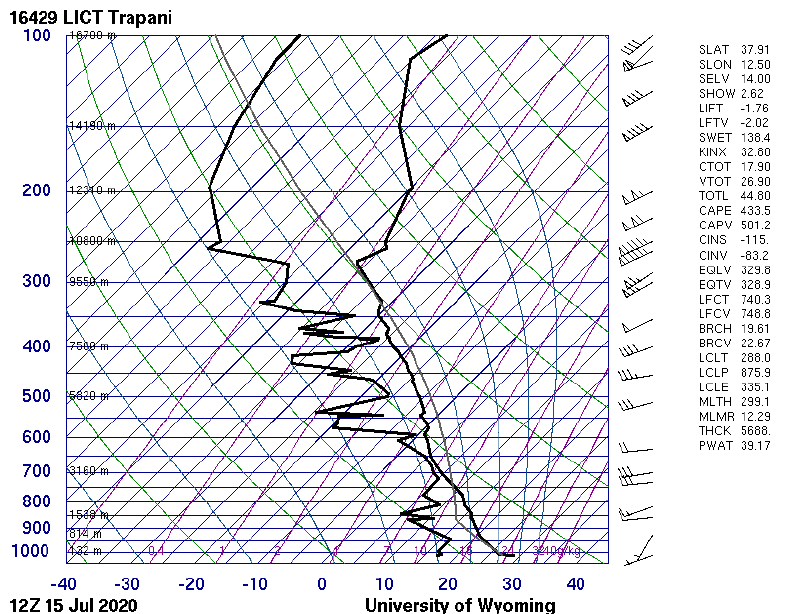
Figure 14. Skew-T diagram obtained from a radio sounding carried out in Trapani Birgi at 12:00 UTC of 15 July 2020 (image used by permission from the University of Wyoming, see http://weather. uwyo.edu/upperair/sounding.html (accessed on 16 May